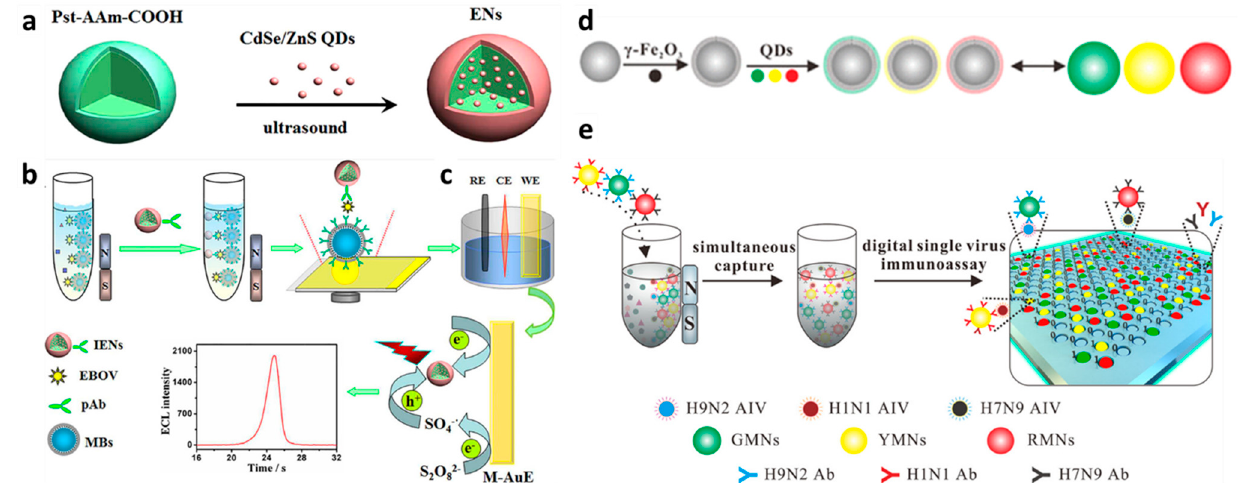
Figure 3. Schematic diagram of polymeric nanospheres (ENs) from poly(styrene/acrylamide). ( a ) Illustration of fabrication of QDs encapsulated − poly(styrene/acrylamide) electroluminescence nanospheres (ENs). ( b ) Magnetic separation and sandwich immunoreaction. ( c ) The electroluminescence detection assay in K 2 S 2 O 8 solution. Adapted with permission from [36] . Copyright 2017, American Chemical Society. ( d ) Fabrication process of multifunctional nanospheres using poly(styrene/acrylamide). ( e ) Illustration of the digital virus immunoassay for multiplex avian influenza virus detection. Adapted with permission from [38] . Copyright 2019, American Chemical Society.